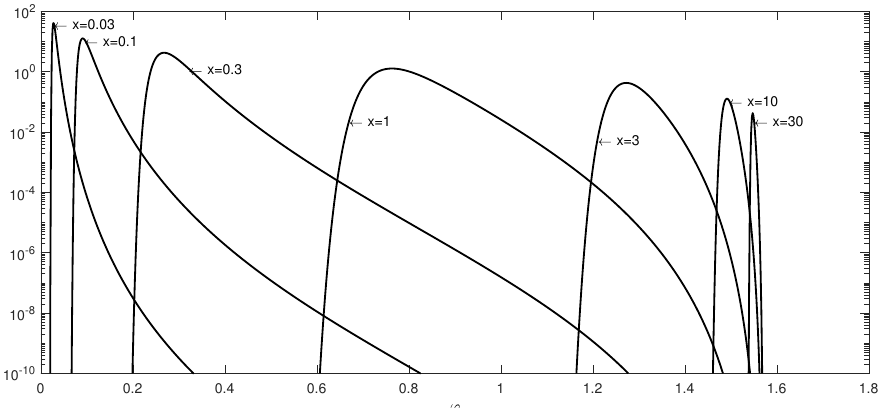
Figure 7. The integrand of the integral representation (3) depending on the variable ϕ for α = 1.1, θ = 0 and specified values of x